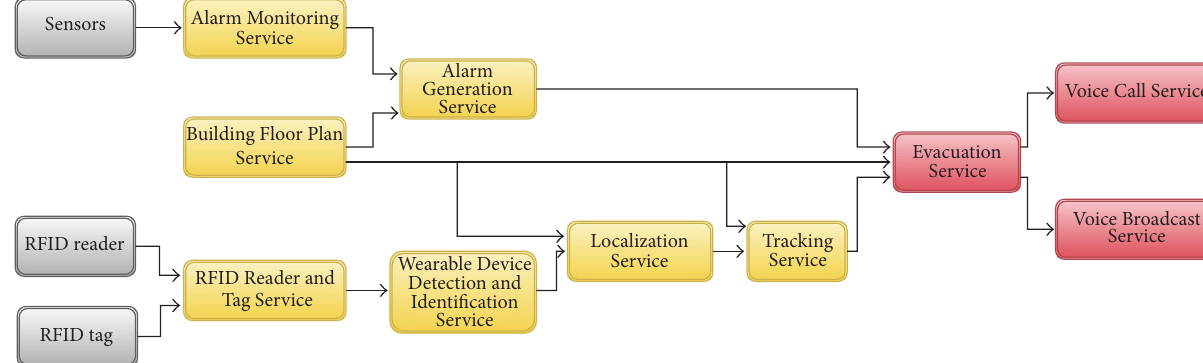
Figure 4: Services defined in Emergency Evacuation Service model and input-output relationship.